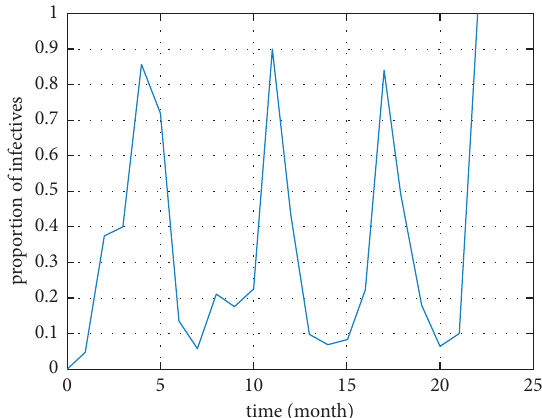
Figure 5: Proportion of the infective curve.